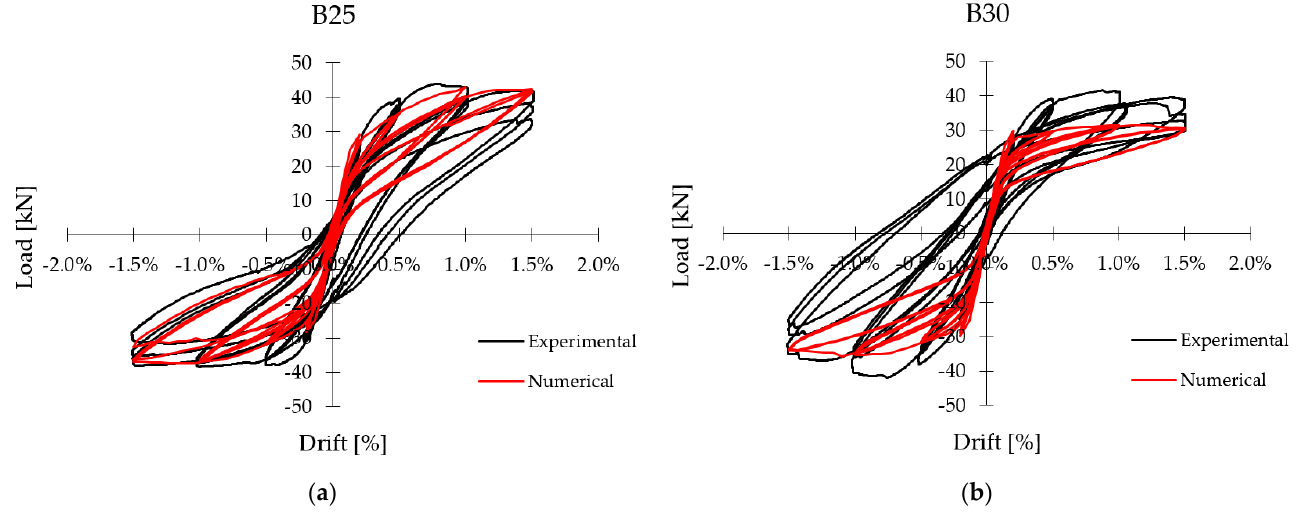
Figure 15. Comparison between experimental and numerical response, corroded columns, MS 3. ( a ) Column B25, ( b ) Column B30.